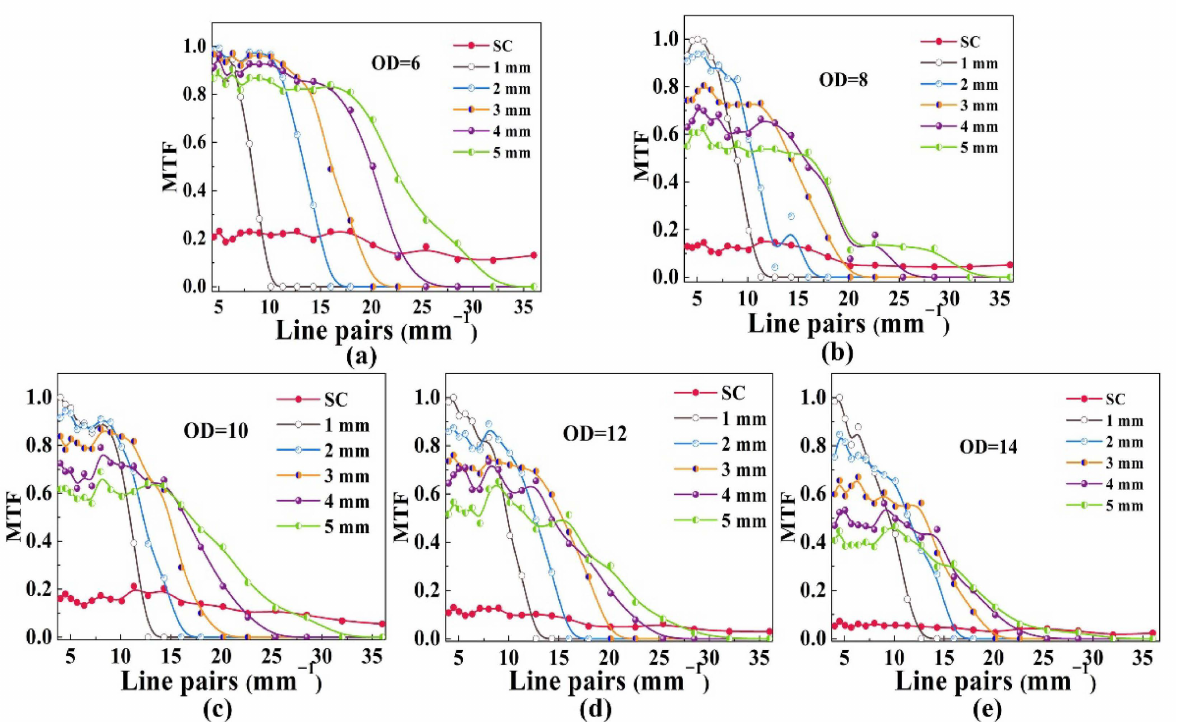
Figure 4. MTF curves for imaging using SC illumination with and without Fourier spatial gate at different ODs: ( a ) OD = 6, ( b ) OD = 8, ( c ) OD = 10, ( d ) OD = 12, and ( e ) OD =